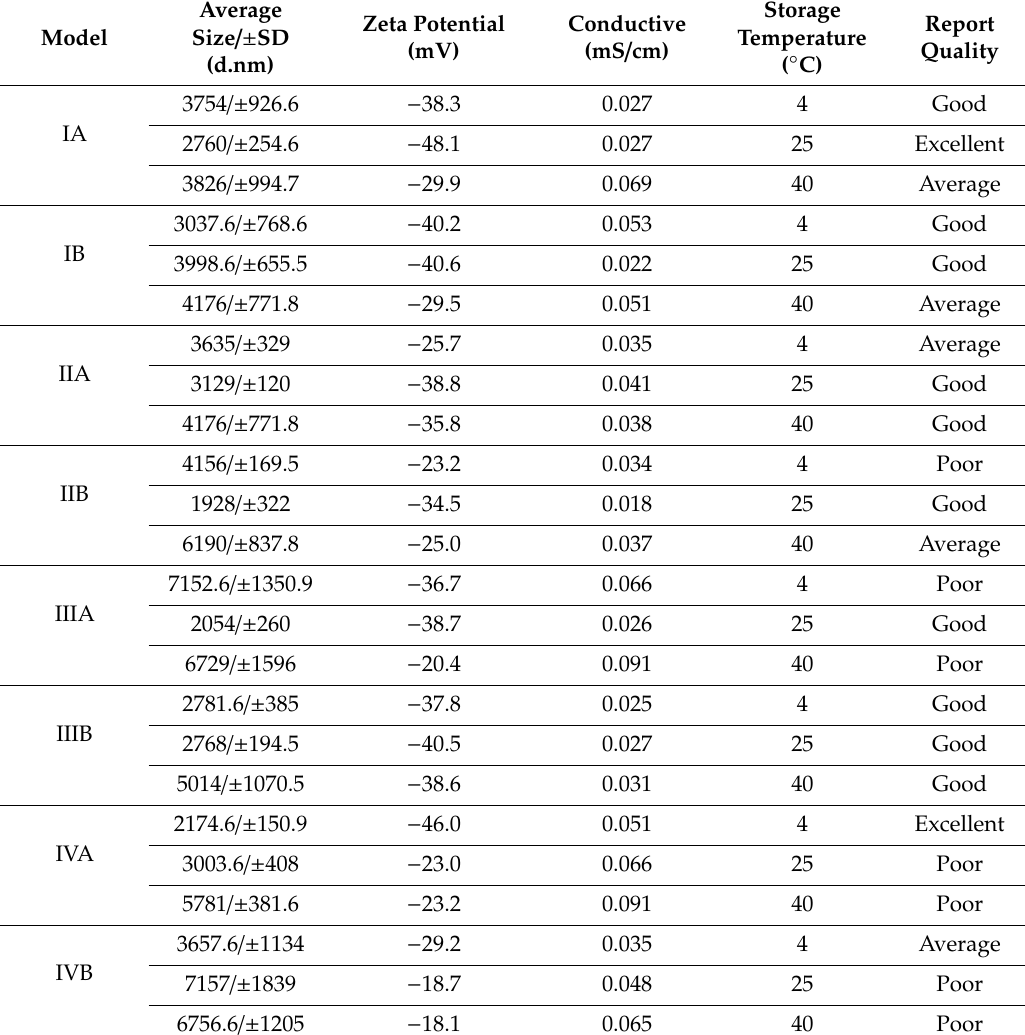
Table 5. Globule size and zeta values of model IA to IVA and their controls at 4 ◦ C, 25 ◦ C and 40 ◦ C after 28